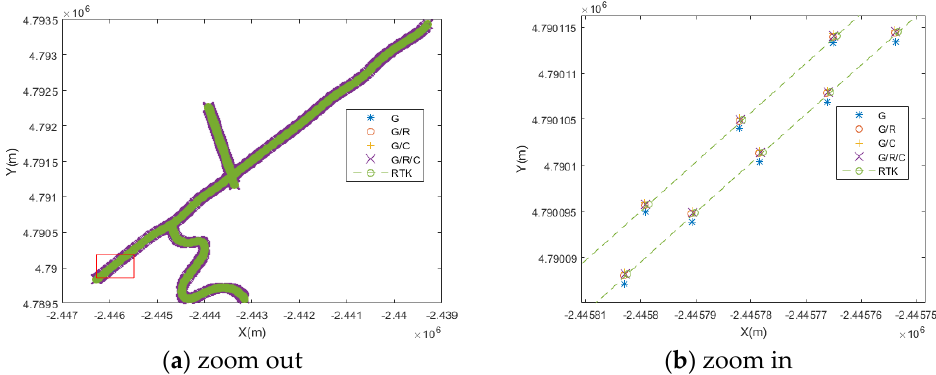
Figure 4. Multi-constellation kinematic PPP and real-time kinematic (RTK) positions. Table 3. The mean errors of the four processing cases (unit: m 2 ). STD: standard deviation.